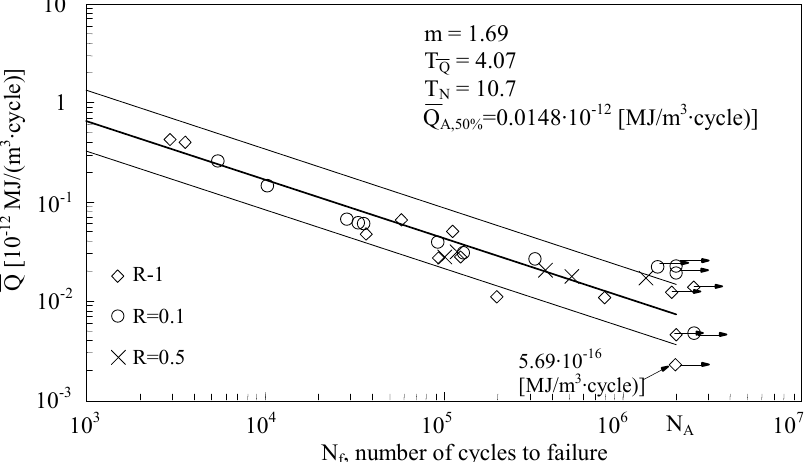
Figure 10: Fatigue data of Fig. 4 analysed in terms of the equivalent energy released as heat by a unit volume of material per cycle Q . Scatter bands are defined for 10 and 90% survival